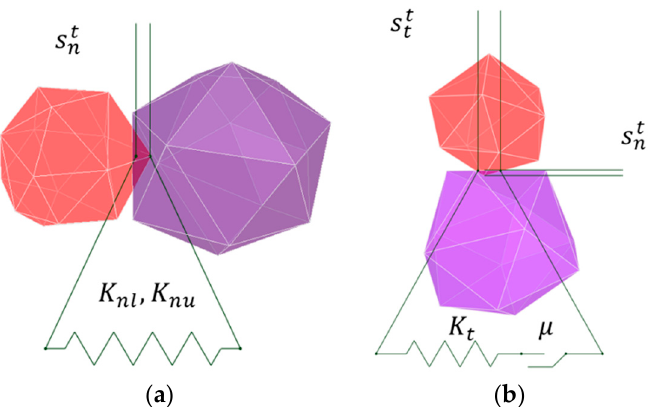
Figure 2. Configurations of particle contact forces: ( a ) HLS normal force model; ( b ) LSCL tangential force model.